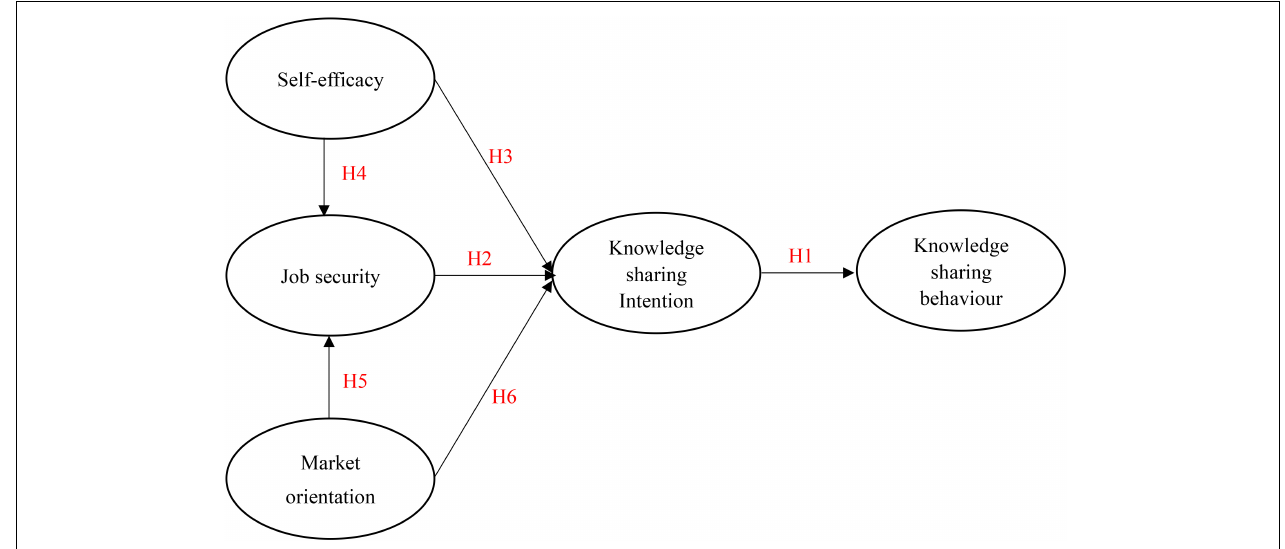
FIGURE 1 | Research